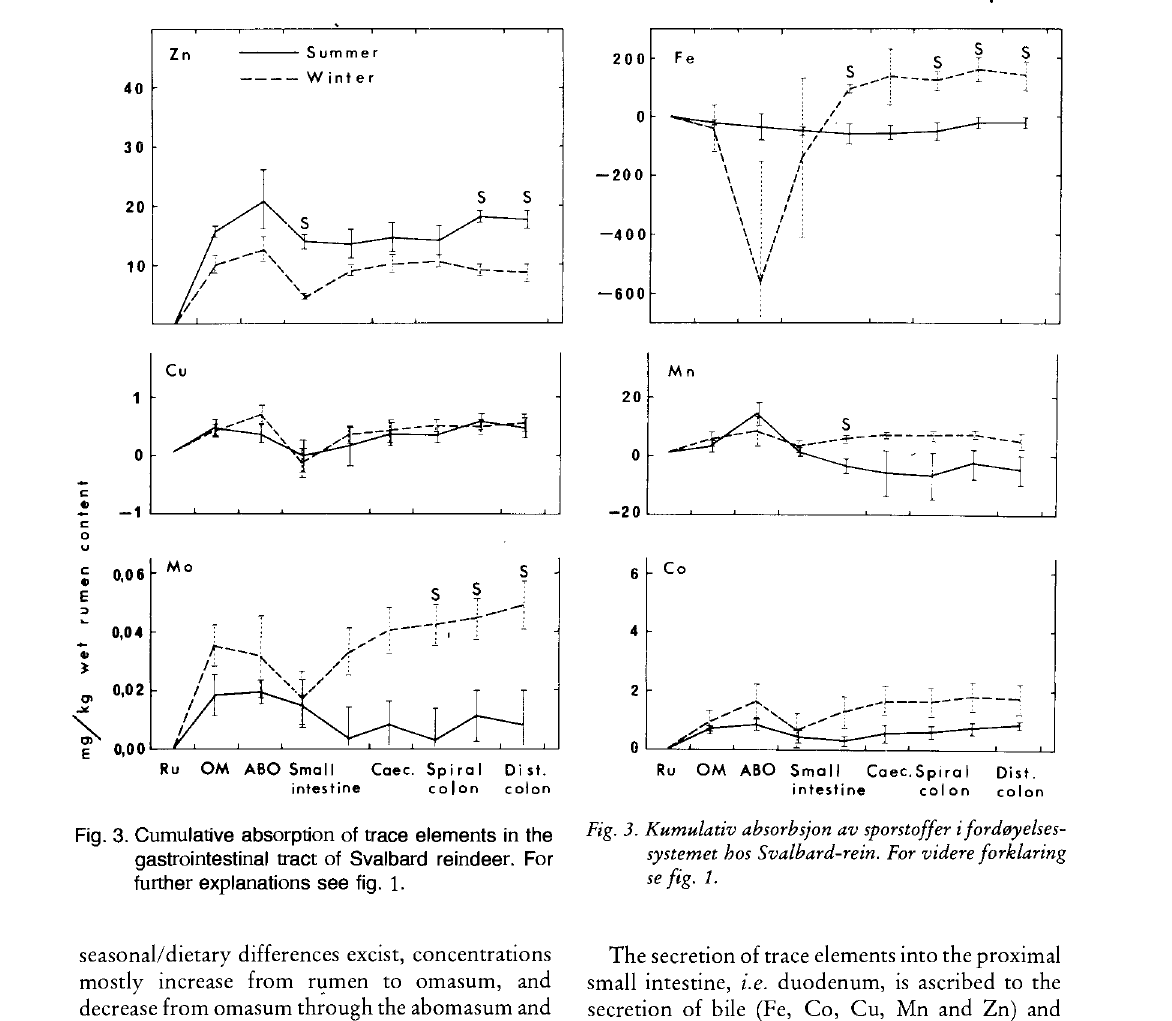
Fig. 3. Kumulativ absorbsjon av sporstoffer i fordøyelses systemet hos Svalbard-rein. For videre forklaring se fig.